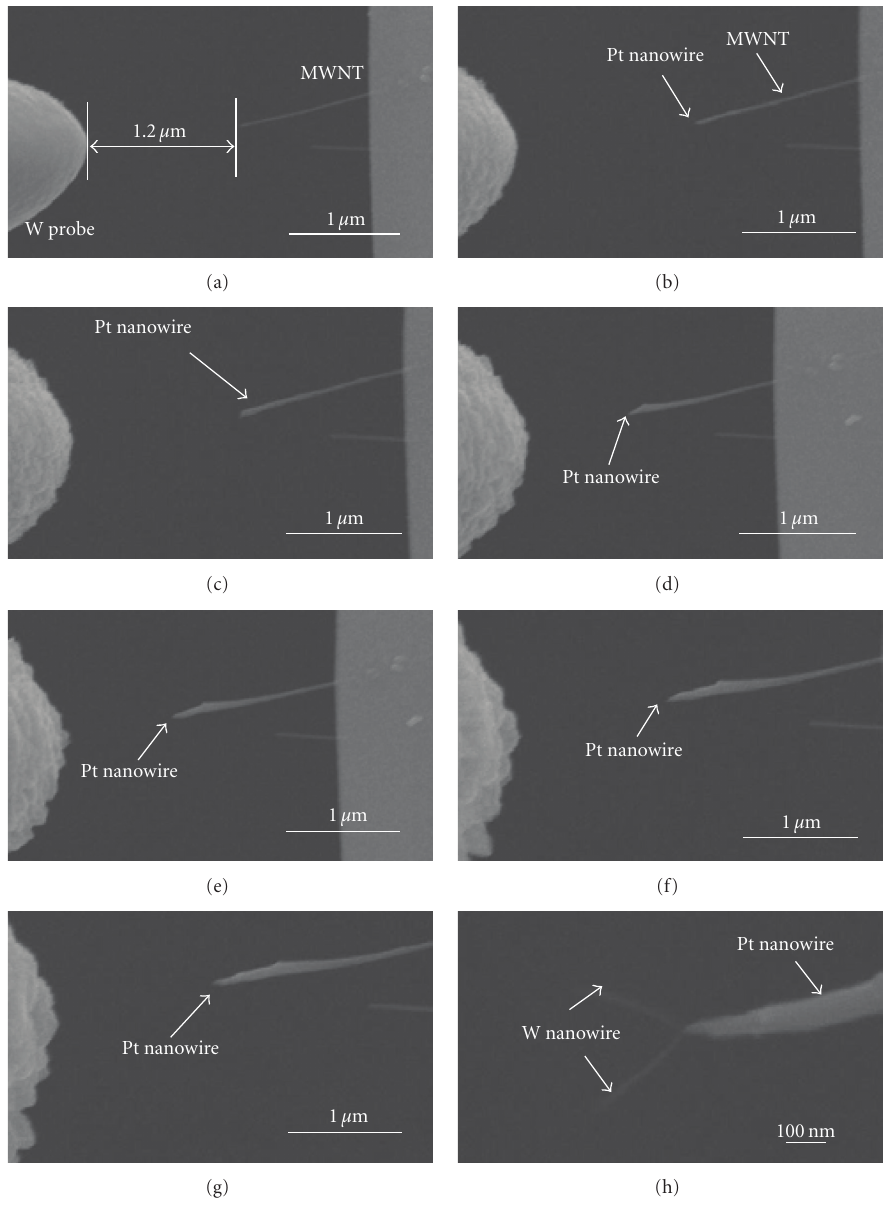
Figure 4: Images showing hybrid nanowire growth inside the FESEM chamber: (a) a 500nA constant field emission current was applied for 1 min to grow the platinum nanowire; (b) the platinum nanowire grew 38nm from the MWCNT tip; (c) a 1 μ A constant current was again applied in which the platinum nanowire diameter increased from 28 to 40nm; (d) a 1 μ A constant current was applied for 2 minutes in which the platinum nanowire grew a further 101nm; (e) the gap between the nanowire tip and tungsten probe was reset to 1.1 μ m, and a 1 μ A constant current was applied for 2 minutes causing the nanowire to grow a further 151nm; (f) the gap was reset to 1.2 μ m, and a 1 μ A constant current was applied for 2 minutes causing the nanowire to grow a further 45nm; (g) the gap was reset to 1.2 μ m, and a 1 μ A constant current was applied for 2 minutes causing a further 73 nm of growth; (h) the tungsten nanowire grew from the platinum